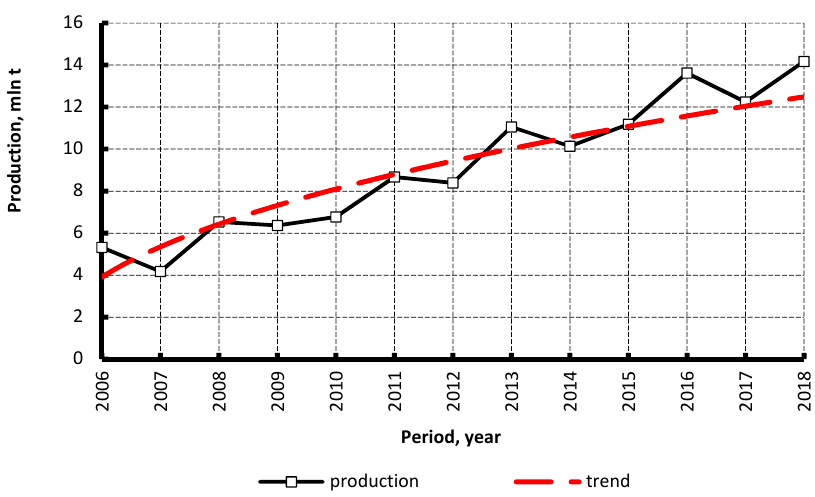
Figure 1. Sunflower seed production history [28].